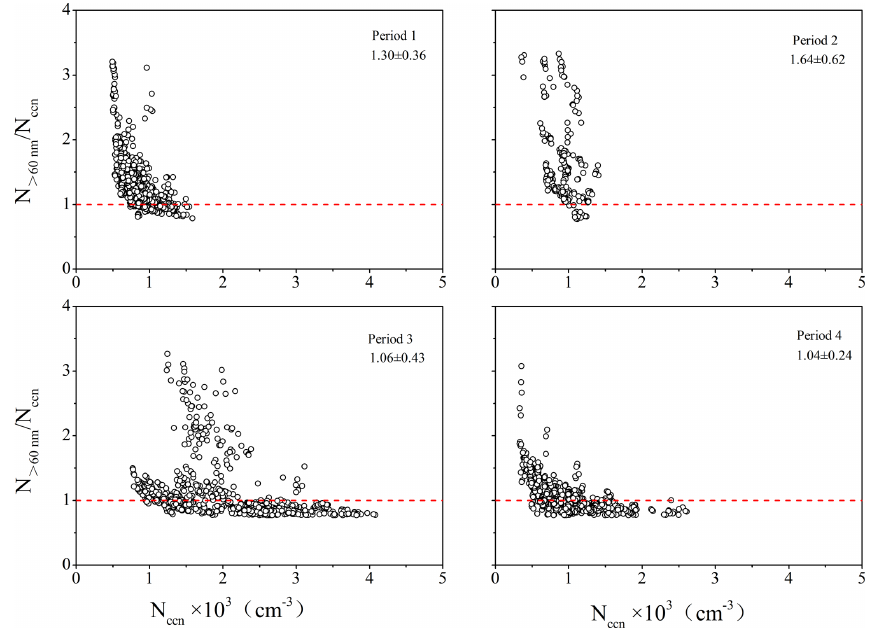
Figure 4. The ratios of N > 60nm /N ccn as a function of N ccn at SS of 0.4% in different periods.